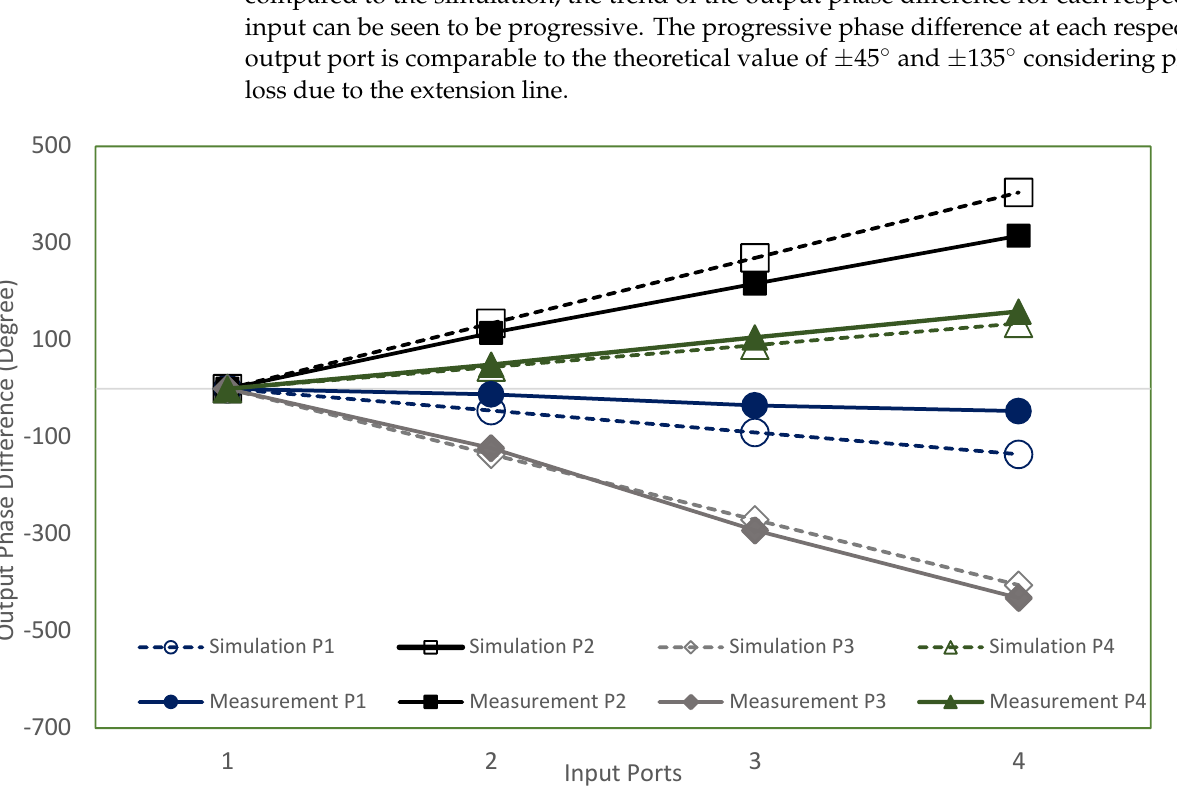
Figure 26. The output phase simulation and measurement.